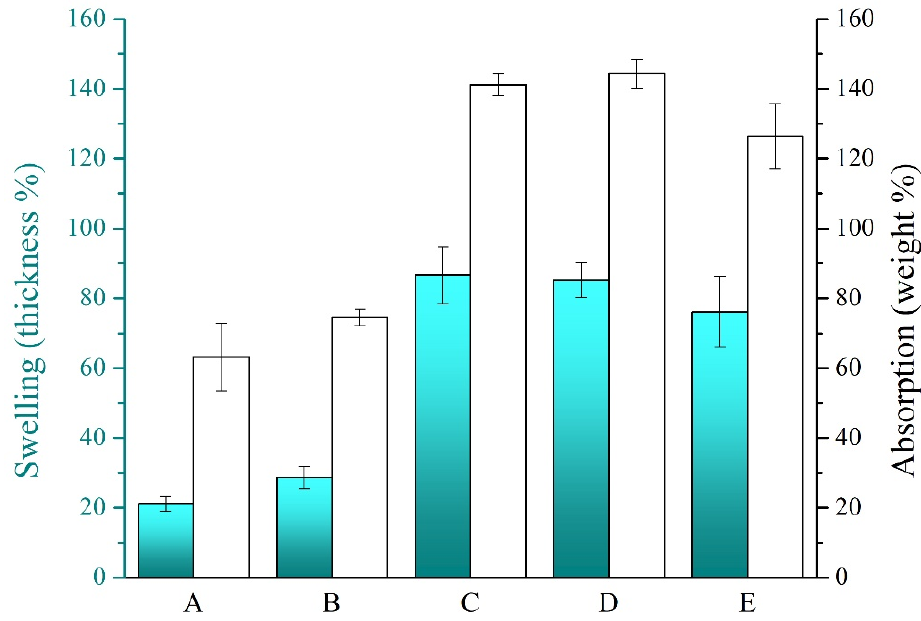
Figure 15. Percentages of thickness swelling (blue) and water absorption (white) of particleboard samples with and without additives.